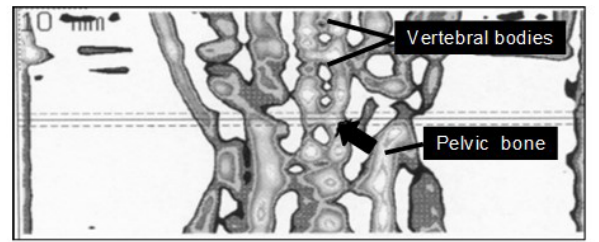
Figure 1. Tomographic scout view of the distal femur and the prox- imal tibia of a marmoset monkey recorded by quantitative com- puter tomography. The arrow points to the left proximal tibia. Ra- diographs were taken in the reference line (solid line) and 1.0mm proximally and distally from it (dashed lines). The image refers to a square of 2 . 8cm × 6cm.